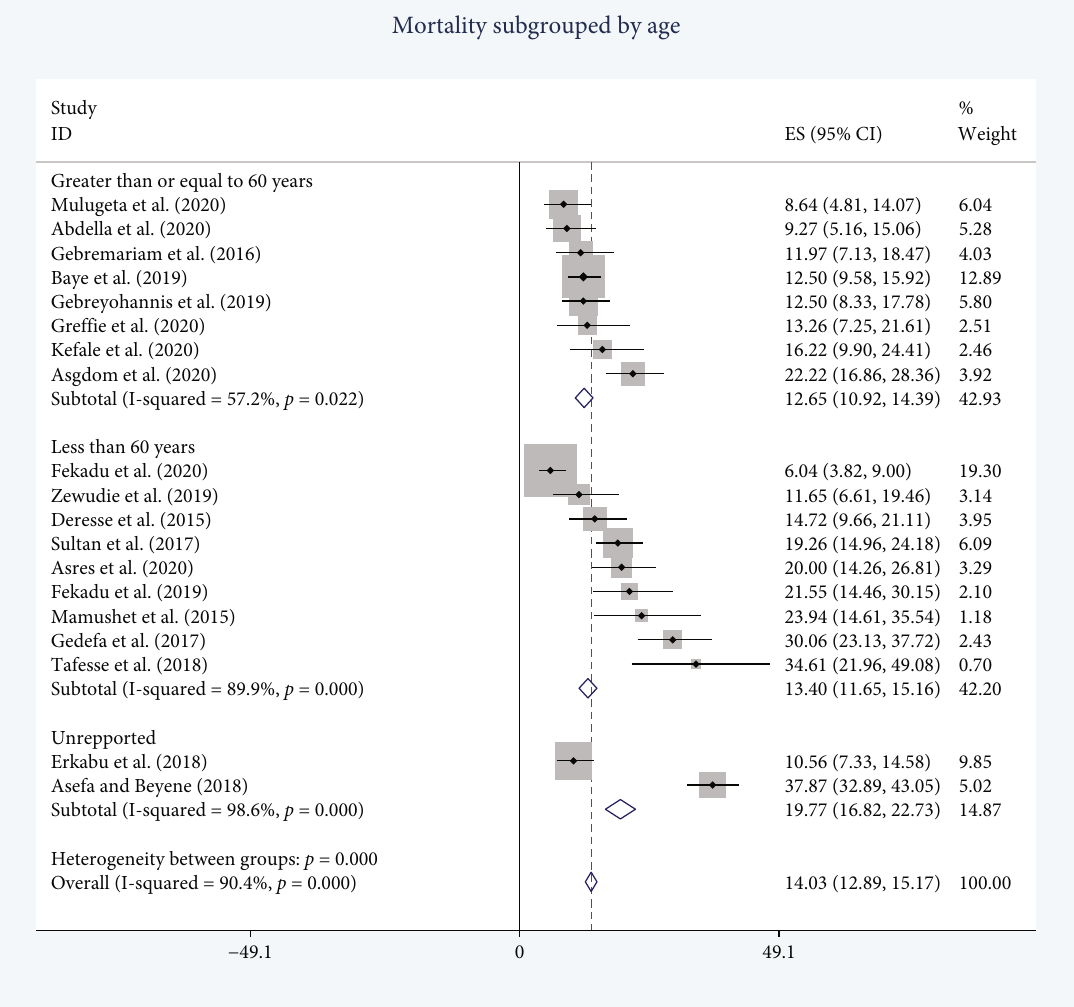
Figure 4: Forest plot of pooled in-hospital stroke mortality subgrouped by